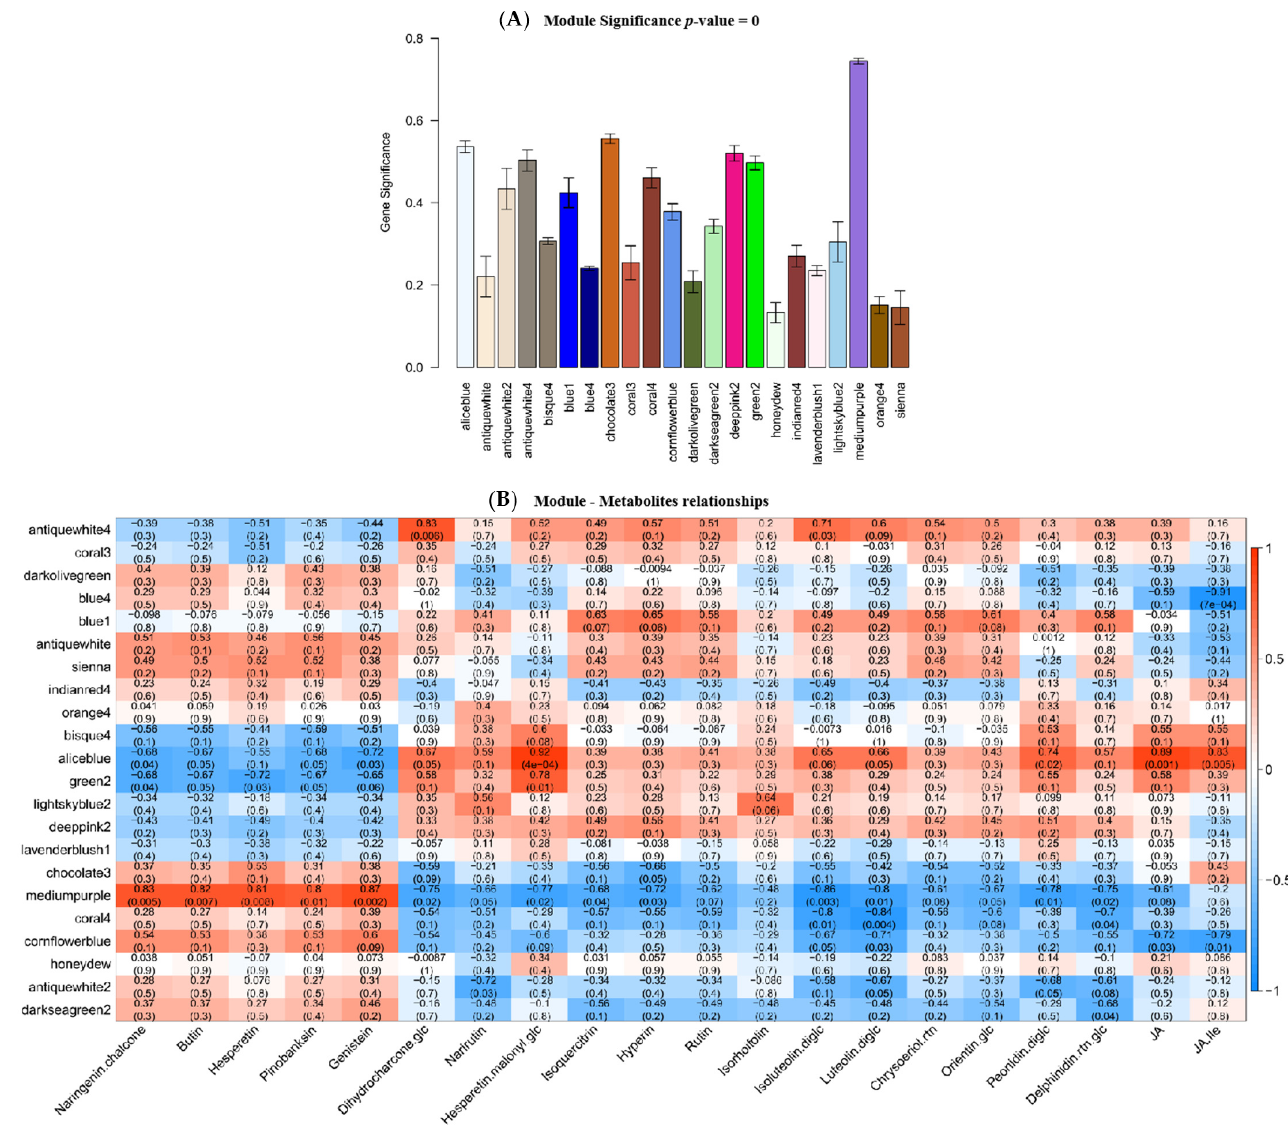
Figure 3. Gene coexpression analysis of light- or K-treated D. officinale . ( A ) The co-expressed gene modules in light- or K-treated D. officinale gene identified by WGCNA. ( B ) Correlation analysis of the co-expressed gene modules and metabolites. The correlation coefficient was placed in the red box, while the p -value is in brackets. The full information about the correlation the co-expressed gene modules and metabolites were listed in Table S1.